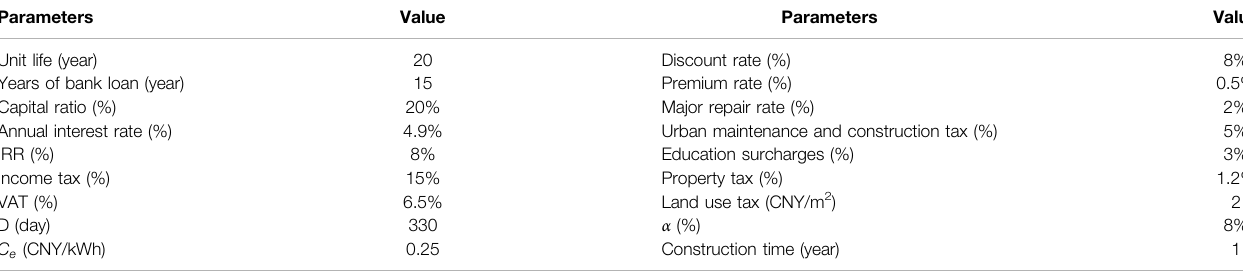
TABLE 3 | Common parameters of EES projects.